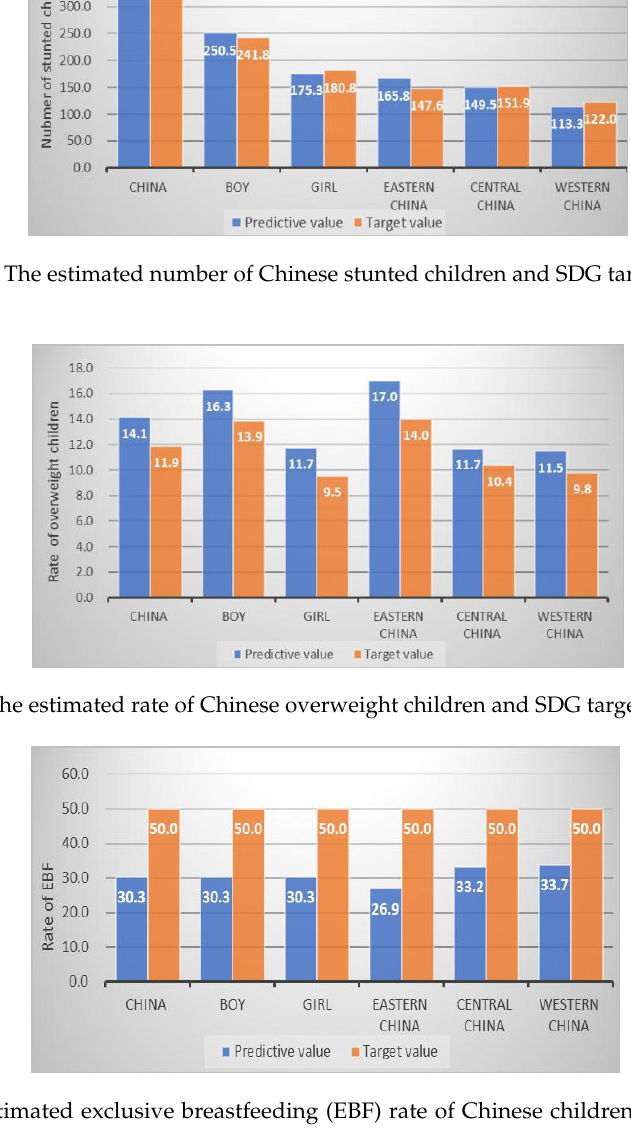
Figure 2. The estimated number of Chinese stunted children and SDG target in 2025.